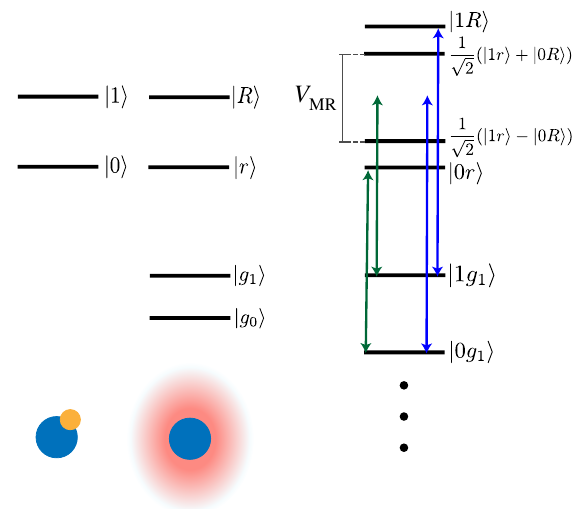
FIG. 4. The relevant energy levels for a blockade-based detec- tion of the molecule. The energy levels for the molecule and Rydberg individually are shown on the left, with the two-body states shown on the right. The dipolar interaction mixes the | 0 R (cid:2) and | 1 r (cid:2) states and results in an energy difference. The green (blue) arrows show the result of a laser attempting to drive the (cid:2) → | r (cid:2) ( | R (cid:2) ) transition, where the drive is off resonant if the | g 1 molecule is in the | 1 (cid:2) ( | 0 (cid:2) )